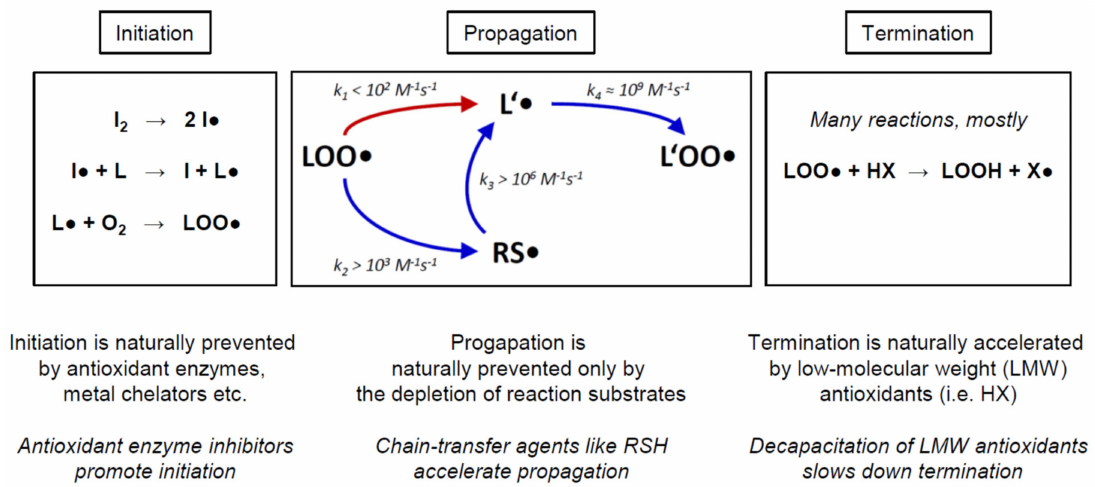
Figure 5. Prooxidative mechanism of chain-transfer agents in living cells, exemplified by the lipid peroxidation reaction. Chemical reactions involving free radicals in living cells frequently present as radical chain reactions (RCRs). RCR possess three kinetically independent elementary steps, namely initiation, propagation, and termination. Antioxidant or prooxidant chemicals and enzymes are generally characterized by their specific interference with only one of these elementary steps. For example, hydrogen peroxide typically accelerates initiation, whereas vitamin E accelerates termination; both do not affect propagation. In contrast, chain transfer agents specifically accelerate radical propagation. More details are provided in the Discussion. The abbreviations denote: initiator (I 2 ); initiator radical (I • ); lipid (L); lipid radical (L • ); molecular oxygen (O 2 ); lipid peroxyl radical (LOO • ); a second lipid (L’, omitted for clarity); a second lipid radical (L’ • ); a second lipid peroxyl radical (L’OO • ); lipophilic thiol (RSH, omitted for clarity); lipophilic thiol radical (RS • ); low-molecular weight antioxidant (HX); lipid hydroperoxide (LOOH); antioxidant radical (X • ); rate constant (k X ). The propagation scheme and the rate constants were adopted from